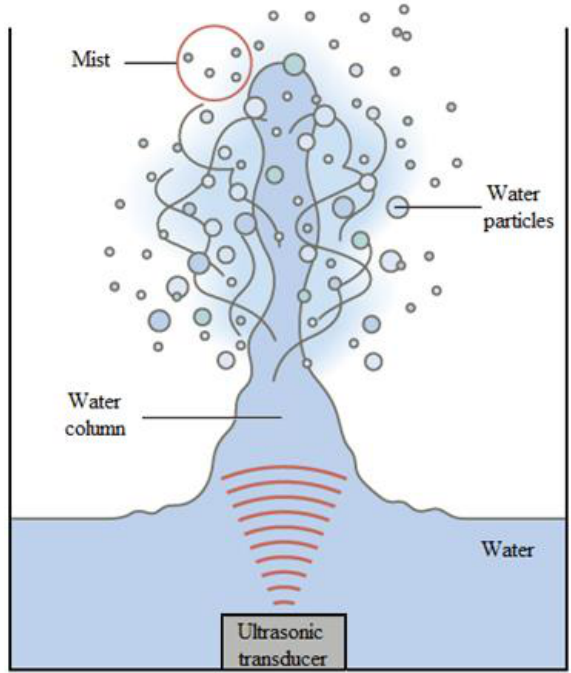
Fig. 2. The behavior of the ultrasonic underwater .